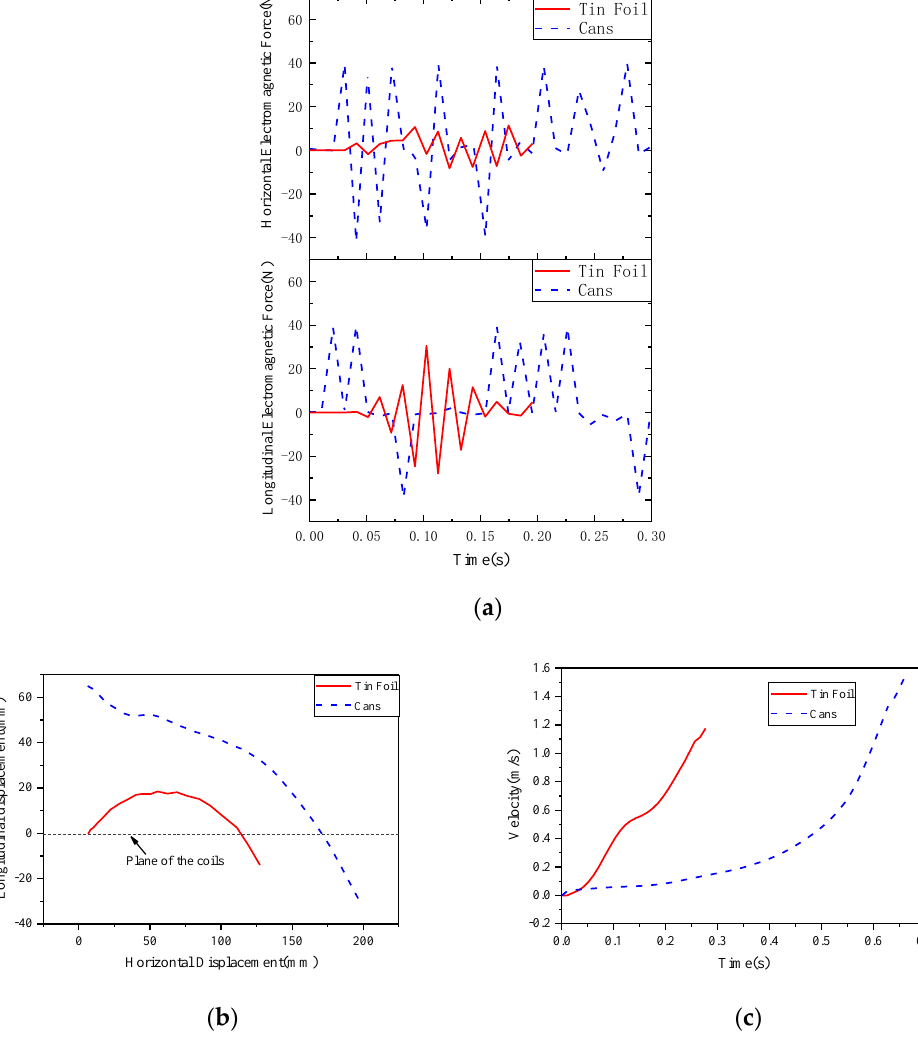
Figure 13. Dynamic characteristics of foil paper and cans. ( a ) EMF; ( b ) movement path; ( c ) velocity.